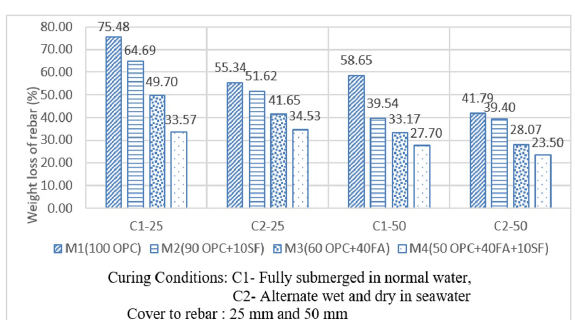
Fig. 9. Weight loss of rebar